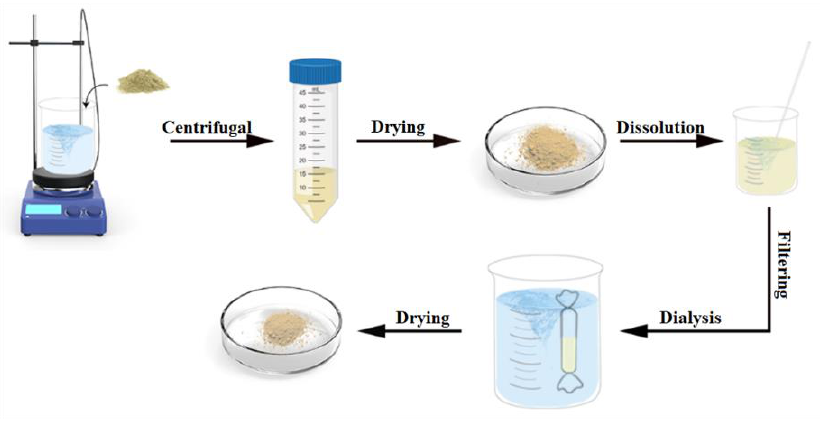
Figure 1. Diagram of silk fibroin extraction.